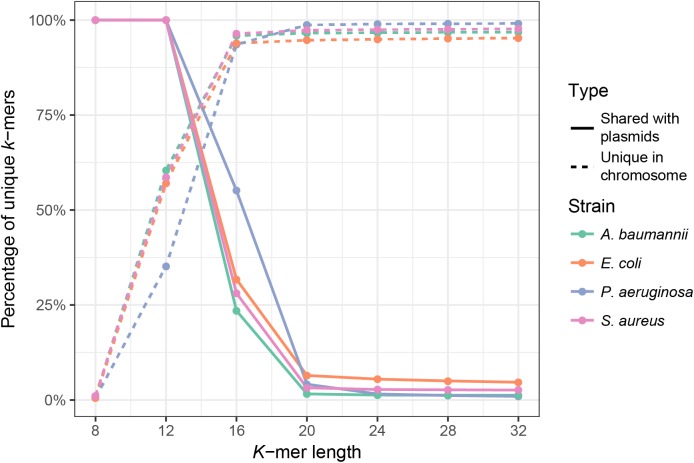
Fraction of unique k-mers in bacteria and unique chromosomal k-mers shared with the plasmid database.Dashed lines indicate the fraction of unique k-mers in the assembled full genome of the bacterium (number of unique k-mers divided by all k-mers of the bacterium), and solid lines indicate the fraction of unique chromosomal k-mers that are also present in the plasmid database.